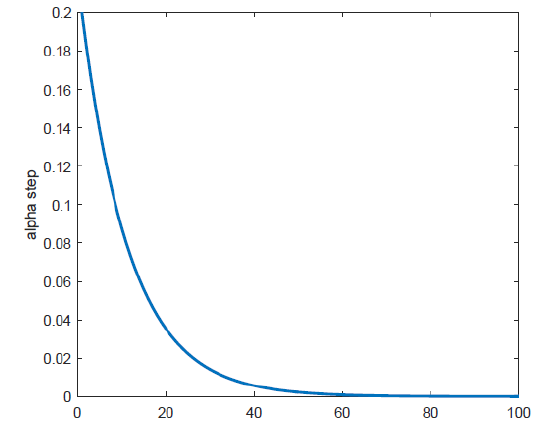
Figure 2. The status of values in different generations.